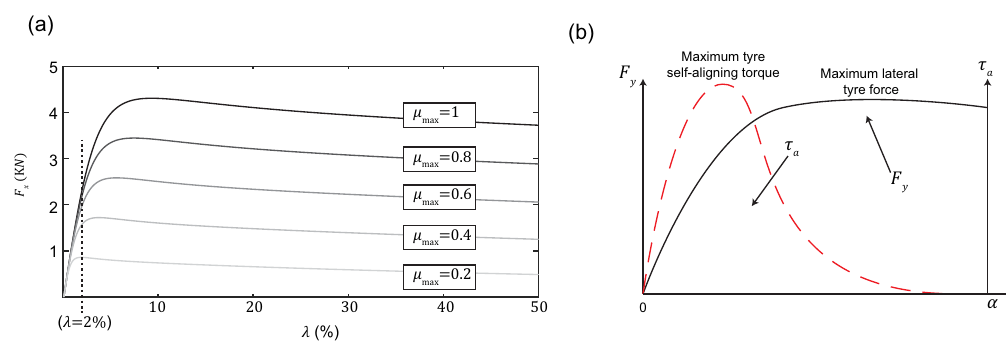
Figure 11. ( a ) Longitudinal forces versus slip ratio λ ( % ) obtained for different µ max values from Tyre SAT-based methods rely on the earlier saturation of the tyre self-alignment torque.